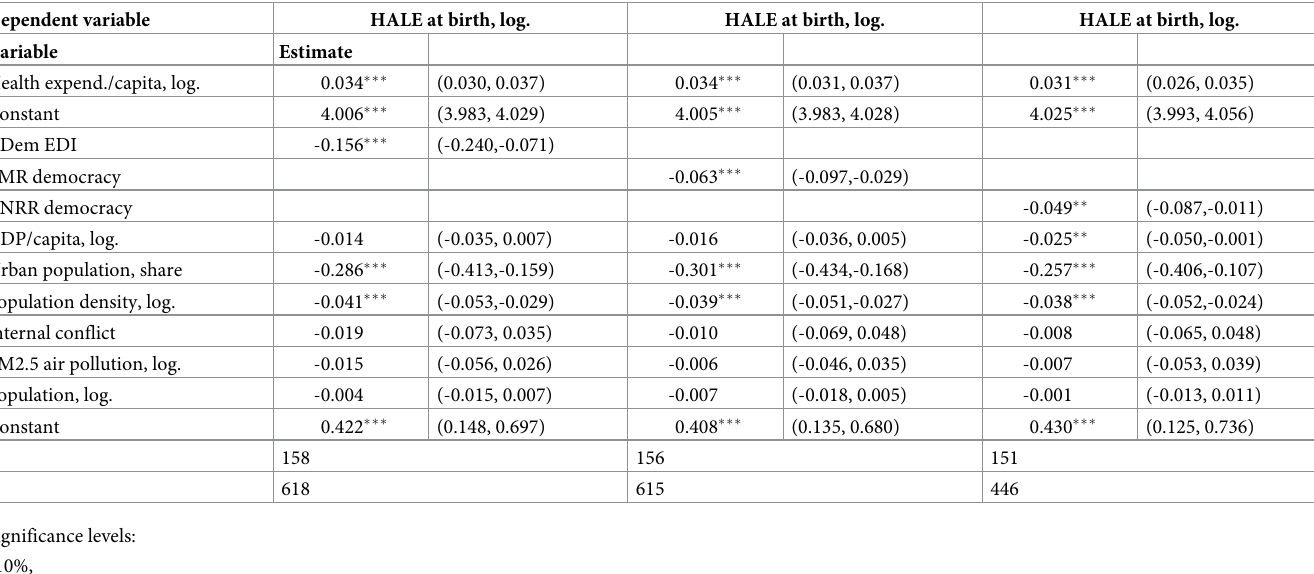
Table 2. SFA results for alternative democracy indicators. Dependent variable HALE at birth, log. HALE at birth, log. HALE at birth,